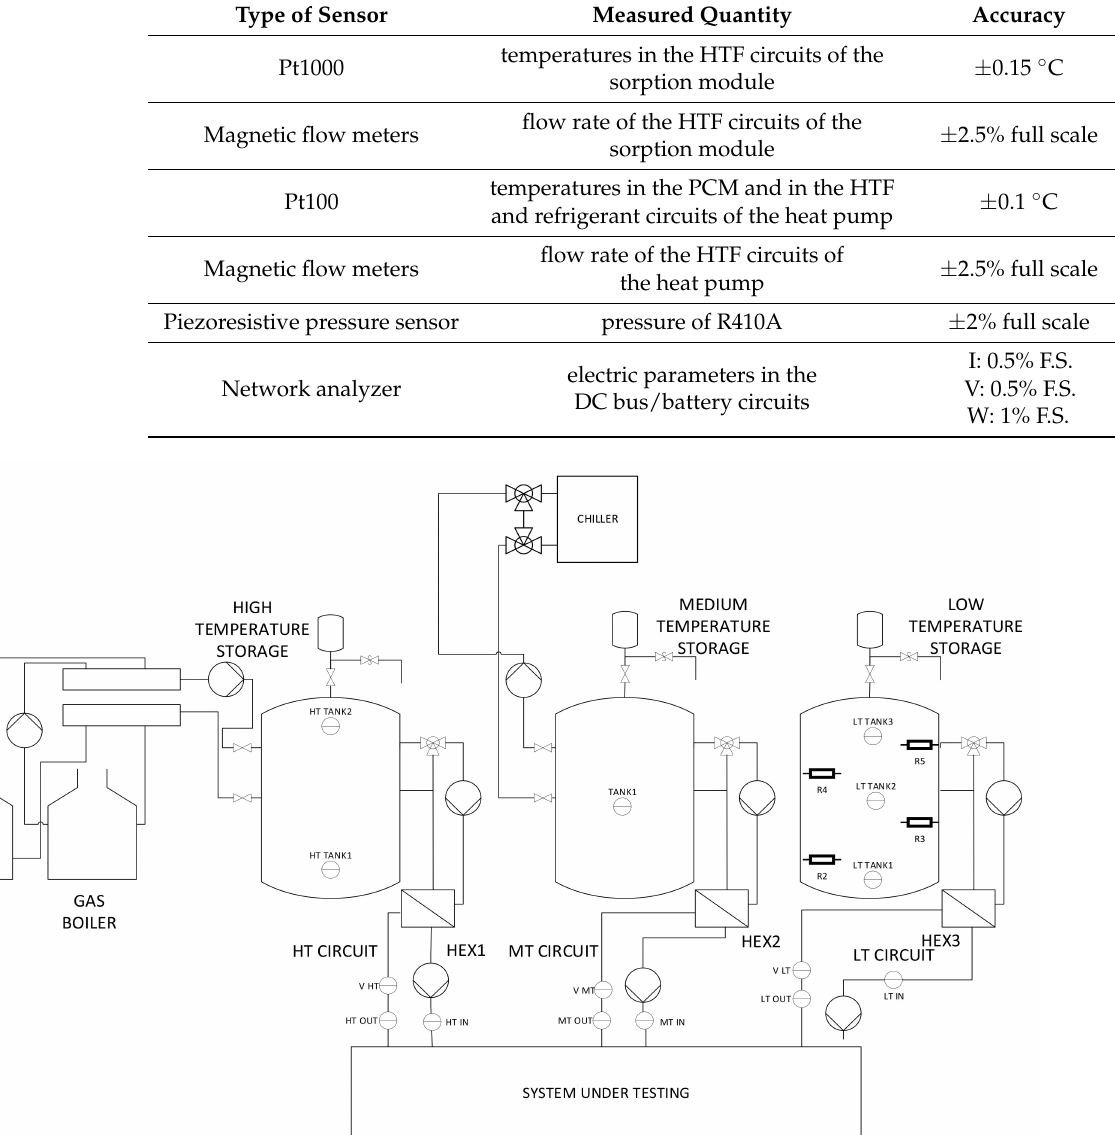
Table 1. Sensors and their accuracy.